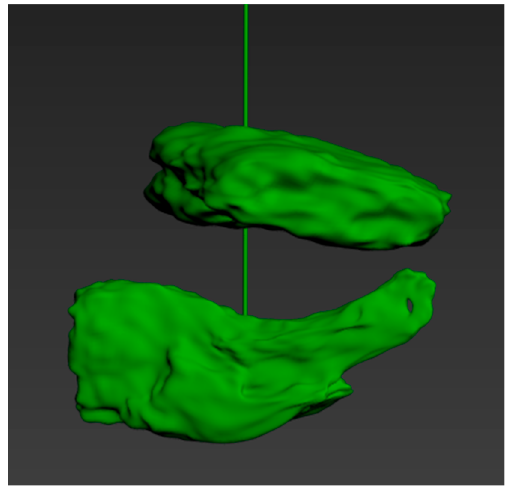
Figure 18. The three-dimensional model of the cave (h3).